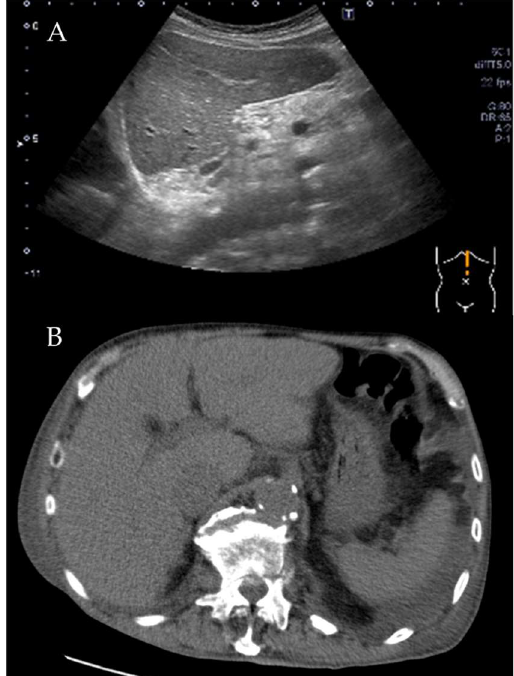
Figure 5. Abdominal echogram ( A ) and computed tomography ( B ) showing chronic changes due to liver congestion.